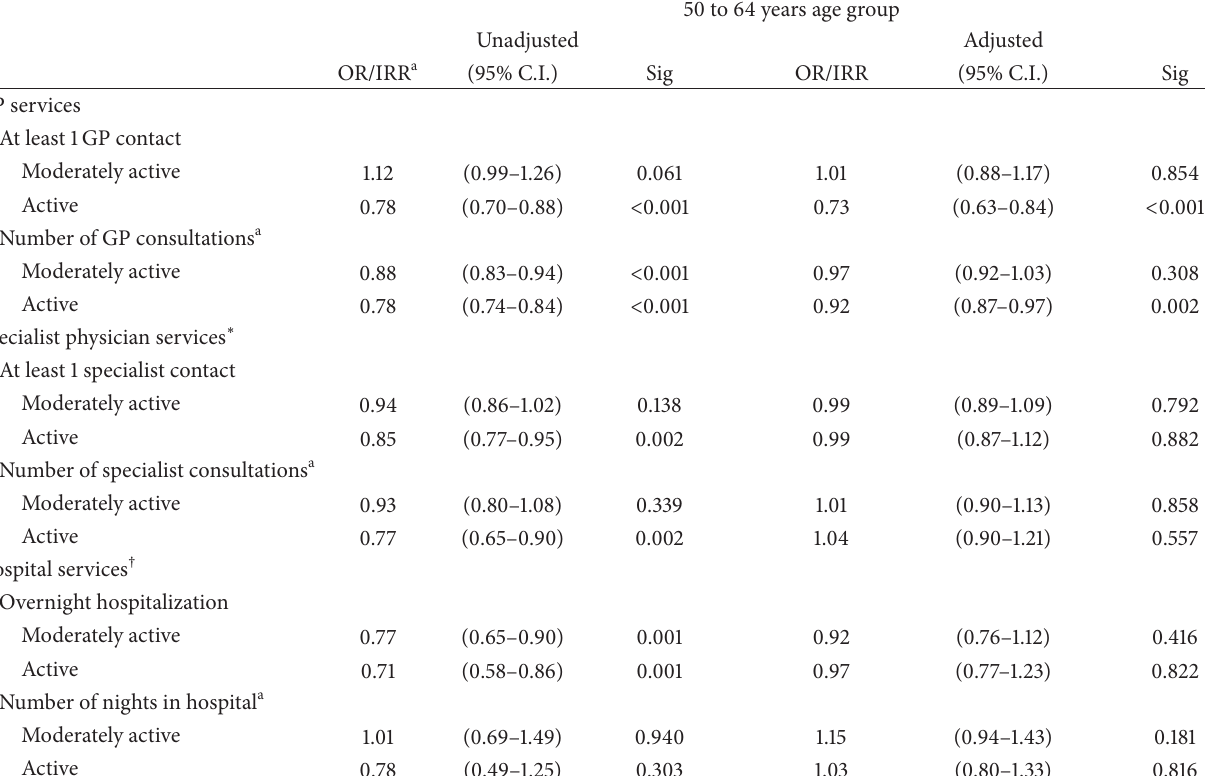
Table 4: The association between LTPA and health services utilization in the 50 to 64 years age group ( 𝑁 =